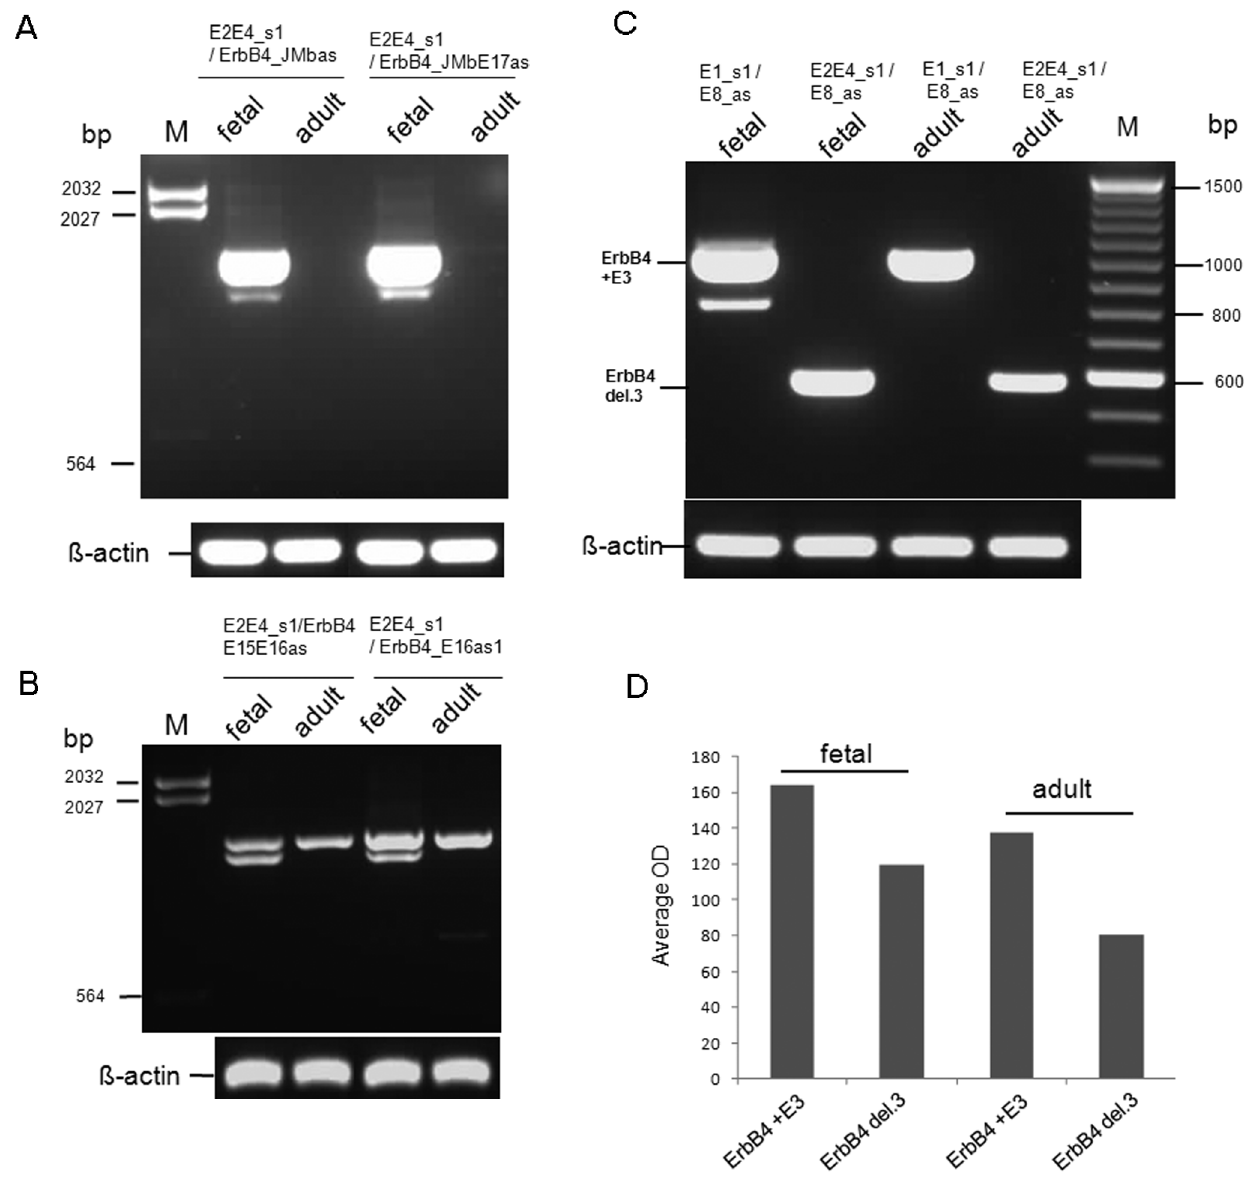
Figure 4. Expression of ErbB4 del.3/JM-b (A) and ErbB4 del.3 JM-a (B) splice isoform mRNAs in the adult and fetal human brain. For verification purposes, dual sets of primers were used for amplification of JM-a and JM-b (as labeled). Predicted amplicon sizes: ErbB4 del.3/JM-b (E2E4_s1 plus ErbB4_JMbas: 1489 bp, upper band and E2E4_s1 plus ErbB4_JMbE17as: 1518 bp, upper band). ErbB4 del.3 JM-a (E2E4_s1 plus ErbB4_E15E16as: 1478 bp, upper band and E2E4_s1 plus ErbB4_E16as1: 1484 bp, upper band). Of note, additional smaller bands were detected in the fetal brain for both del.3/JM-b and del.3/JM-a amplifications. (C) Semi-quantitative RT-PCR analysis of ErbB4 del.3 and ErbB4 + E3 mRNA abundance in adult and fetal human brain. Amplicon sizes ErbB4 + E3 (E1_s1 plus E8_as: 1011bp). ErbB4 del.3 (E2E4_s1 plus E8_as: 578bp). (D) Mean optical density (OD) values for ErbB4 del.3 and ErbB4 + E3 bands in adult and fetal brain. OD values for b -actin were equal across all samples.